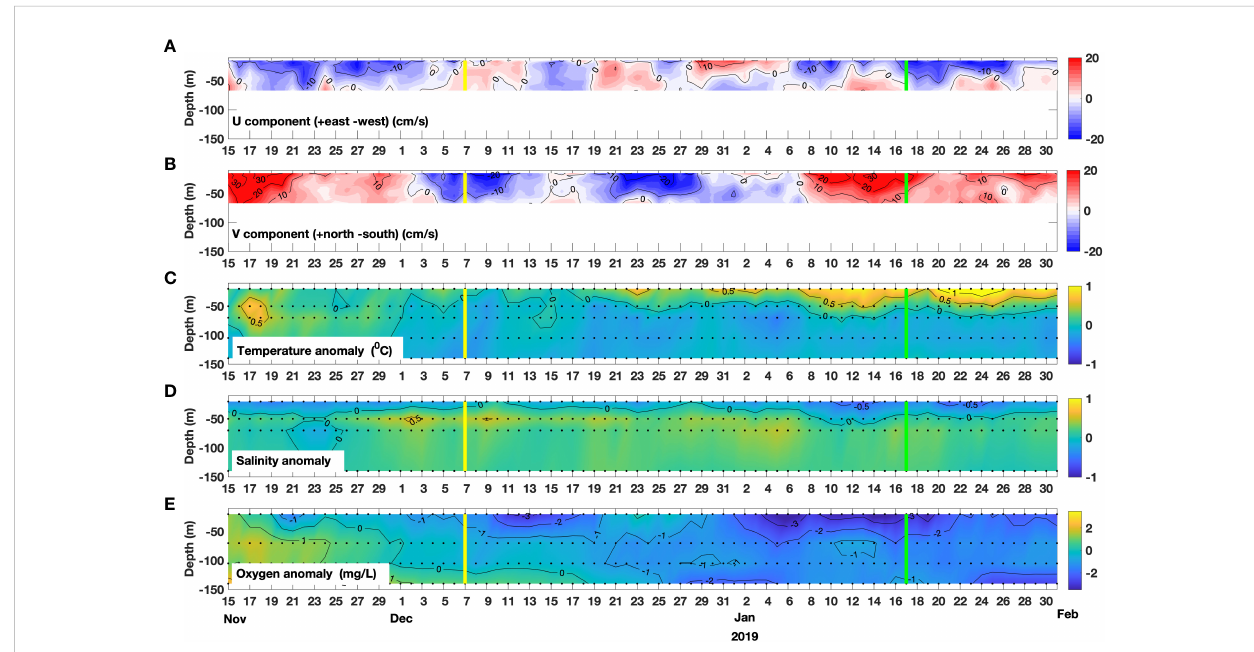
FIGURE 9 Time series of in-situ ocean variables recorded between November 15, 2018 and January 31, 2019. From top to bottom: (A) zonal component U of the ocean current, (B) meridional component V of the ocean current, (C) temperature anomaly, (D) salinity anomaly, (E) oxygen